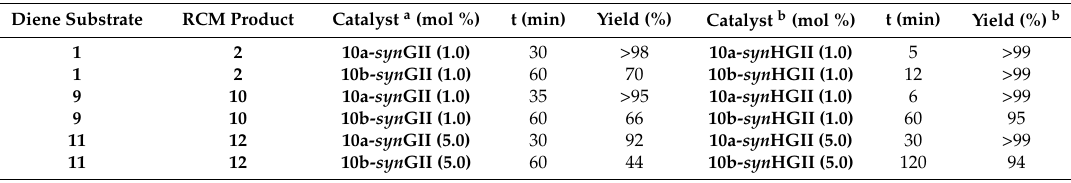
Table 4. RCM of dienes 1 , 9 and 11 with catalysts 10a and 10b